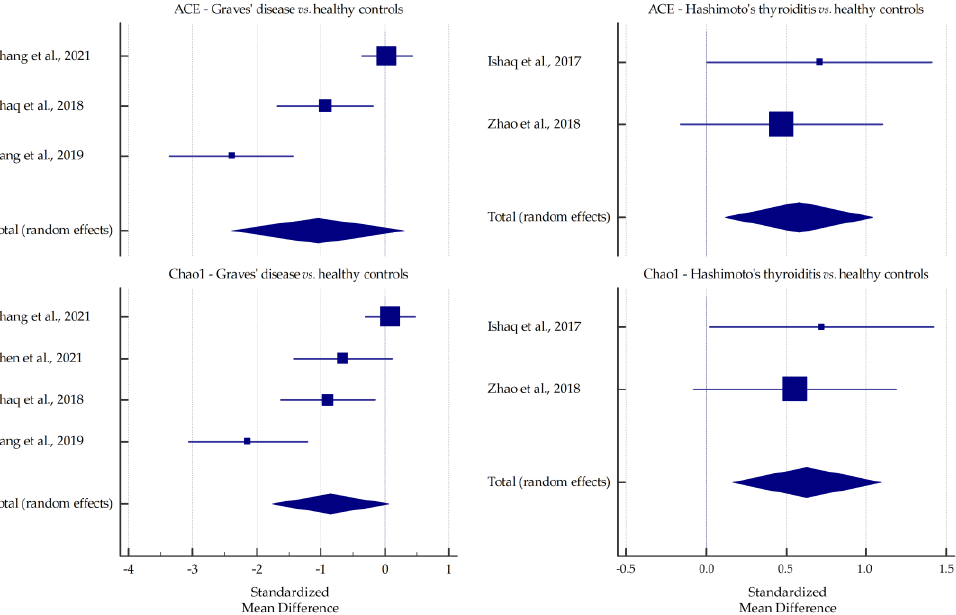
Figure 3. Pooled standardized mean differences in ACE and Chao1, shown separately for Graves’ disease and Hashimoto’s thyroiditis [30–32,39,43,45].